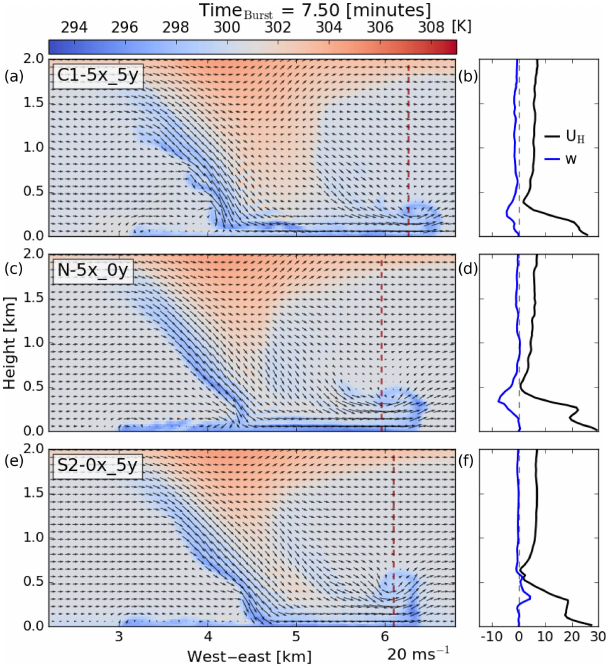
Figure 6. Vertical cross sections along the east–west axis at the center of the domain for the C1–5x_5y (a, b) , N–5x_0y (c, d) , and S2–0x_5y (e, f) cases at time burst = 7 . 5min. Filled contours show temperature (K) with arrows representing the u − w wind field. In panels (b, d, f) are the horizontal velocity and vertical velocity pro- files (black and blue, respectively) for each case at the dashed line in the vertical cross section (of a, c, e ).